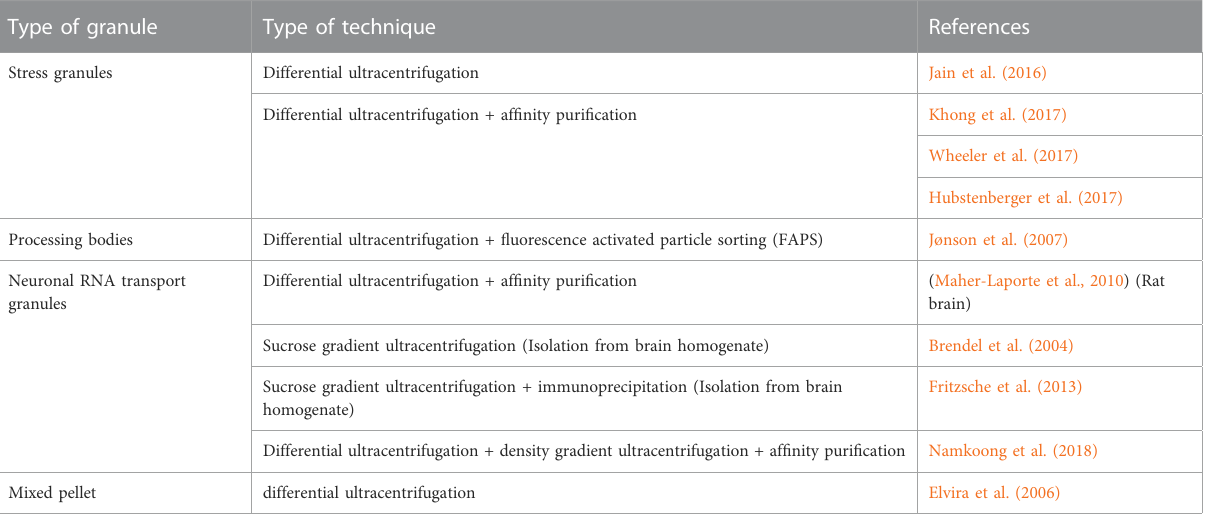
TABLE 2 List of literature of various types of isolation procedures of SGs, PBs, neuronal RNA Transport granules, and RNA granules in general.